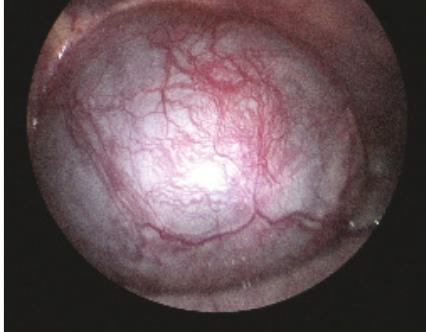
Figure 2: Diagnostic laparoscopy. Bulging cystic mass demonstrat- ing a right abdominoscrotal hydrocele.